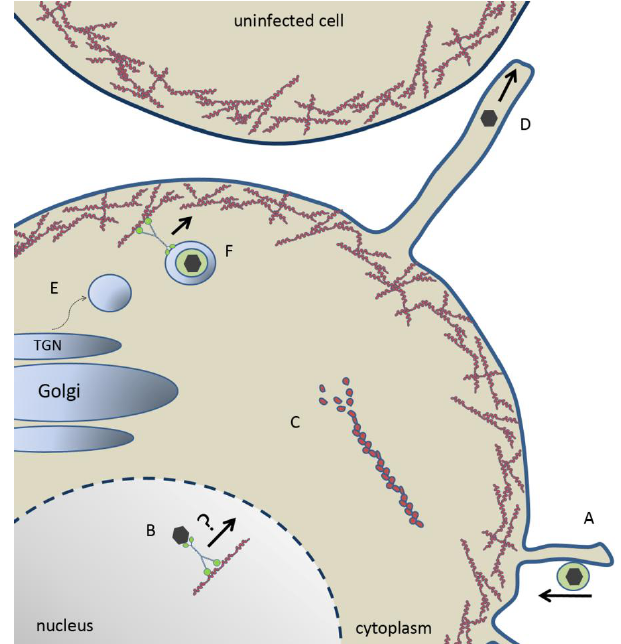
Figure 2. Model of herpesvirus entry, maturation and egress. ( A ) Herpes virion “surfing” towards the plasma membrane along membrane protrusions for entry. ( B ) Capsid trafficking toward the nuclear periphery for budding via a myosin motor on F-actin. ( C ) U 3-mediated depolymerization of actin stess fibers. ( D ) U S membrane projection and cell-to-cell spread of herpesvirus. ( E ) Myosin IIA- and Rab6-dependent fission of nascent vesicles from the Golgi body. ( F ) Enveloped virion within a TGN-derived vesicle trafficking through cortical actin via myosin Va toward the plasma membrane for